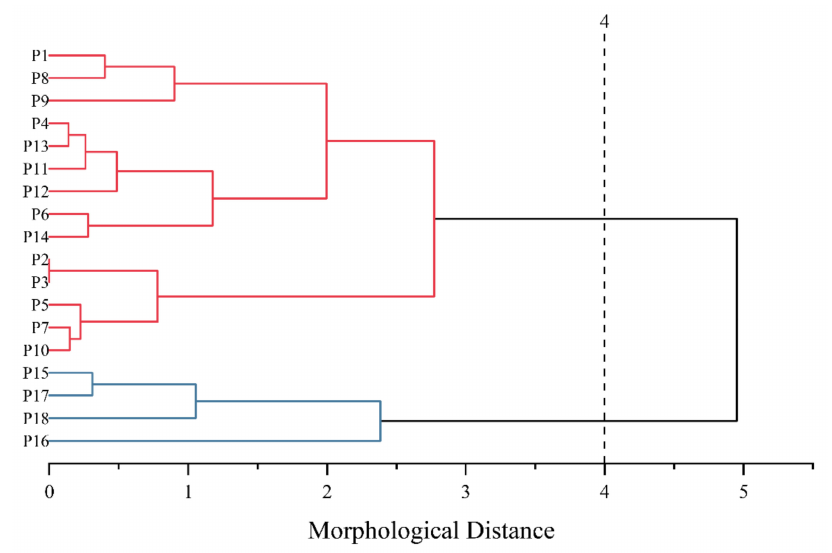
Figure 6. Cluster analysis of 18 tree peony populations based on the pollen polar length. The red line indicates subsect. Vaginatae and the blue line indicates subsect. Delavayanae .